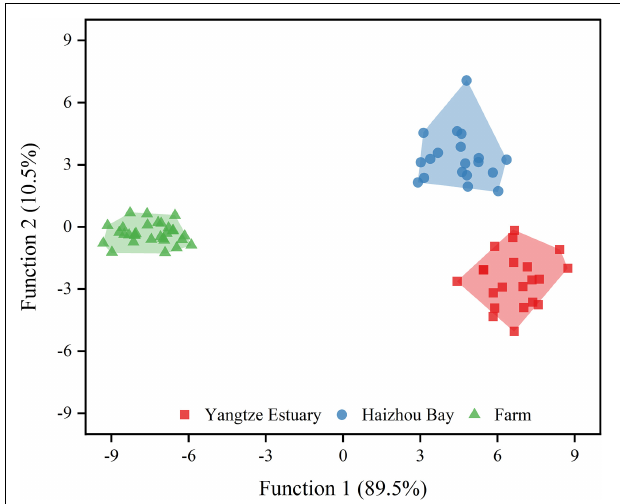
FIGURE 3 | Linear discriminant analysis plots showing the distribution of Rhopilema esculentum from three origins.